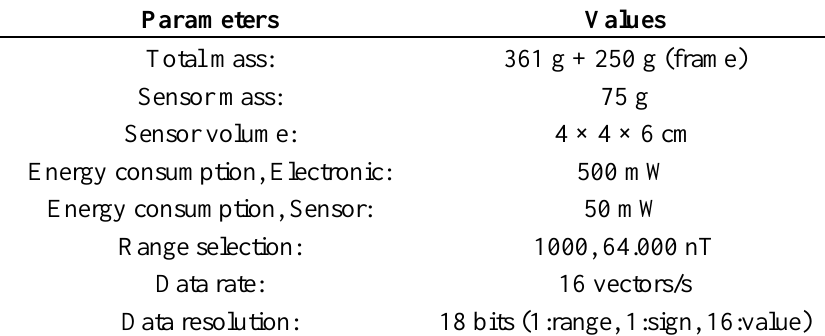
Table 1. Relevant data for the magnetometric sensors used in ST5